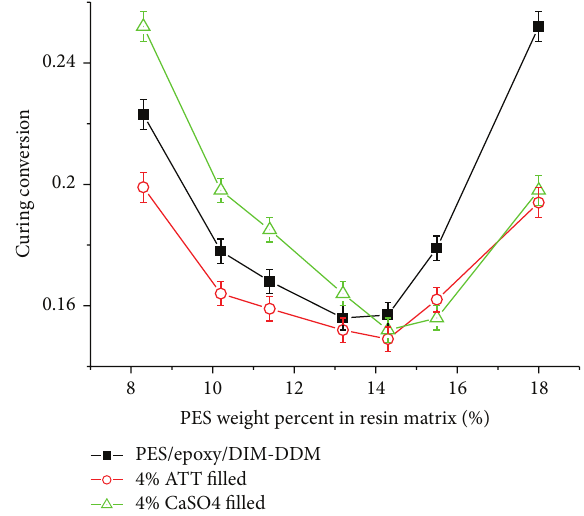
Figure 1: The phase diagram of the PES modified epoxy-hardener systems with and without fillers at 120 ∘